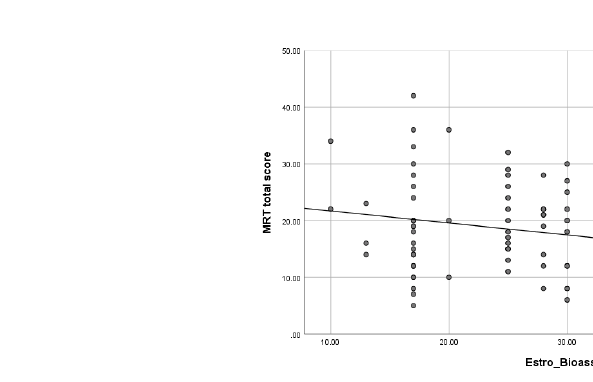
FIGURE 5 Scatterplot of the zero-order correlation (with best- fi tting regression line) between overall accuracy on the Mental Rotation Test (MRT) and the estrogenic potencies of the oral contraceptives (OCs) used in our sample. All OC users were tested during the active pill ingestion phase of the contraceptive cycle (n = 104). OCs higher in estrogen potency were associated with poorer spatial accuracy on the MRT test. Estrogenic potencies for each contraceptive brand were obtained from tables in Dickey and Seymour (67), Managing contraceptive pill patients and other hormonal contraceptives (17 th ed) or earlier editions of the same source, and are based on bioassays or receptor studies. Estro_Bioassay = relative estrogen activity of each OC